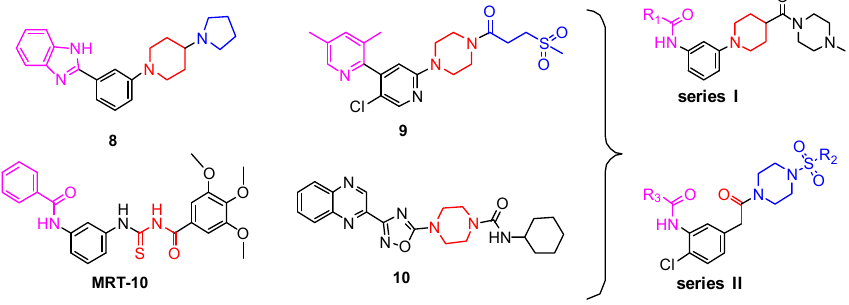
Figure 2. The design strategy of benzamide target compounds.